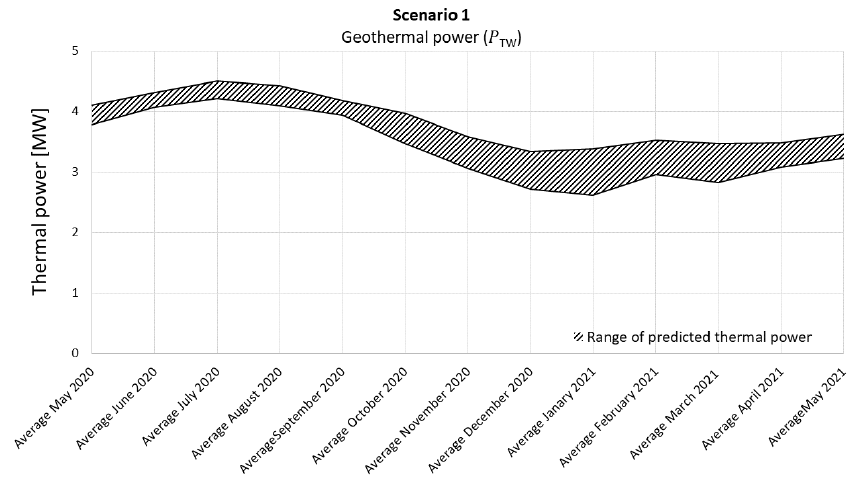
Figure 9. Range of possible thermal power [MW], which might be available during the operational phase of the tunnel for Scenario 1.